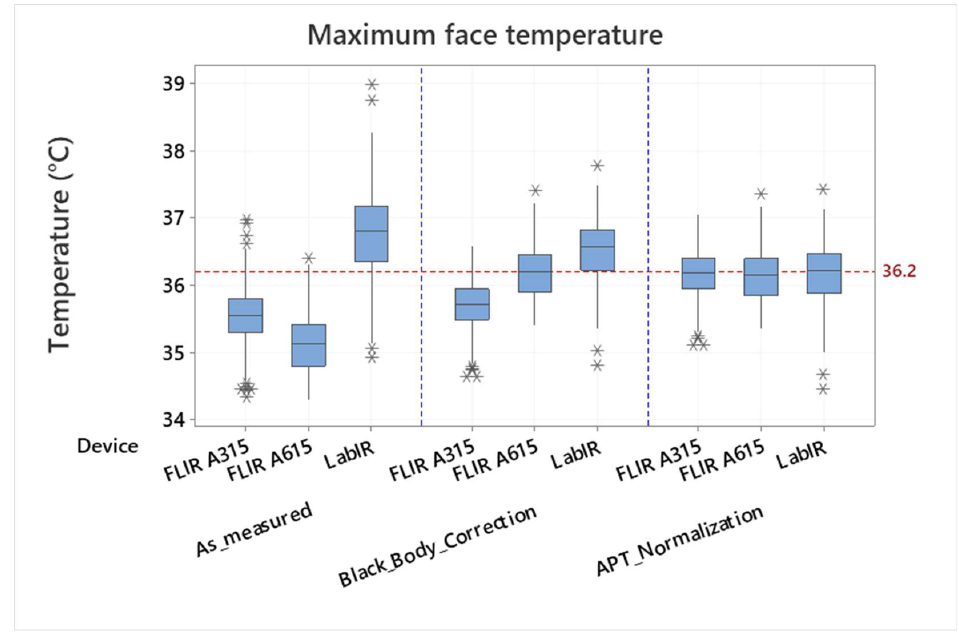
Figure 3. Comparison of face maximum temperature measured by the FLIR A315, FLIR A615 and LabIR IR cameras: as measured (As_measured), corrected by the blackbody (Black_Body_Correction) and normalized according to the armpit thermometer mean values measurement (APT_Normalization). Outliers are identified by asterisks (*).